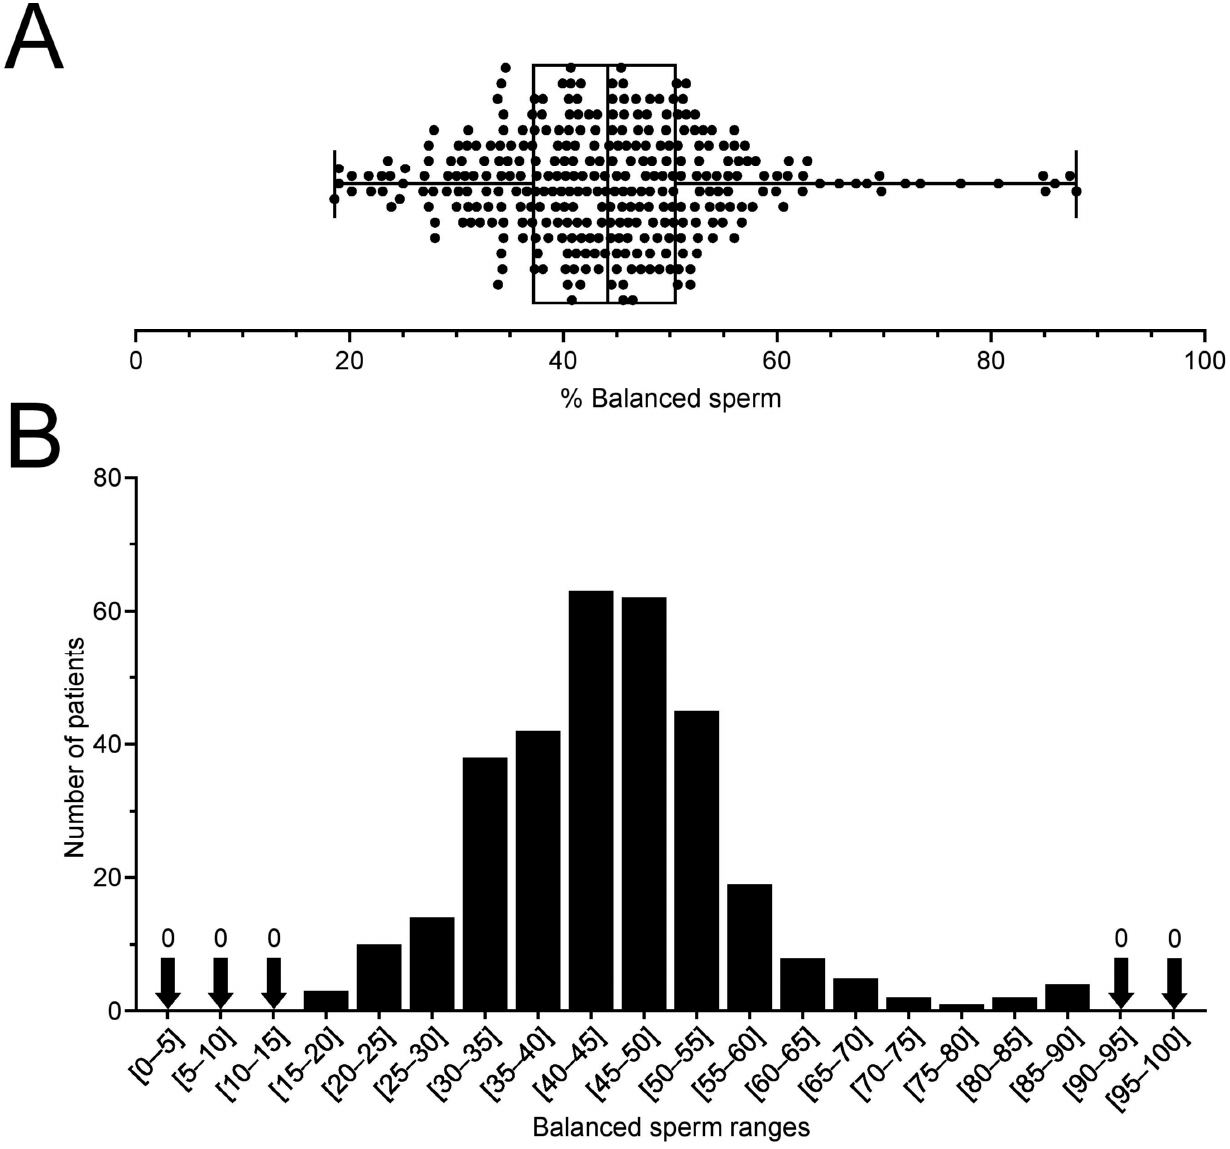
Figure 1. Balanced sperm rates of 318 reciprocal translocation carriers. ( A ) Box-and-whisker plot of balanced sperm rates of all patients with each data point displayed as a dot. ( B ) Histogram of the number of patients according to 5% ranges of balanced sperm.